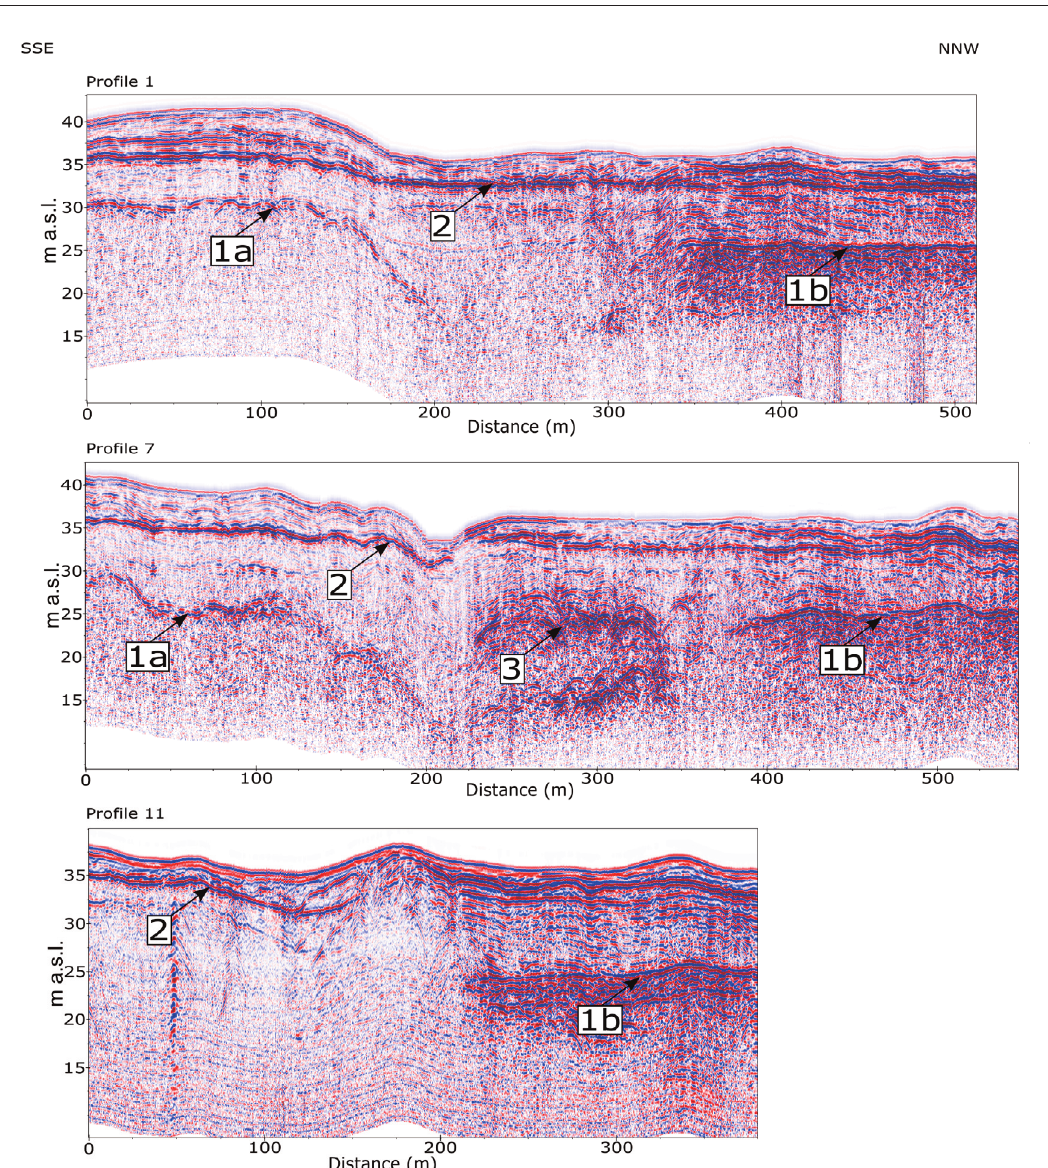
Fig. 3. Radar records obtained by using a 75 MHz antenna. 1a and 1b, reflections related to the base of sandy sediments; 2, reflection associated with the bottom of aeolian deposits; 3, reflections from a local zone of high dielectric contrast. For the location of the profiles, see Fig.